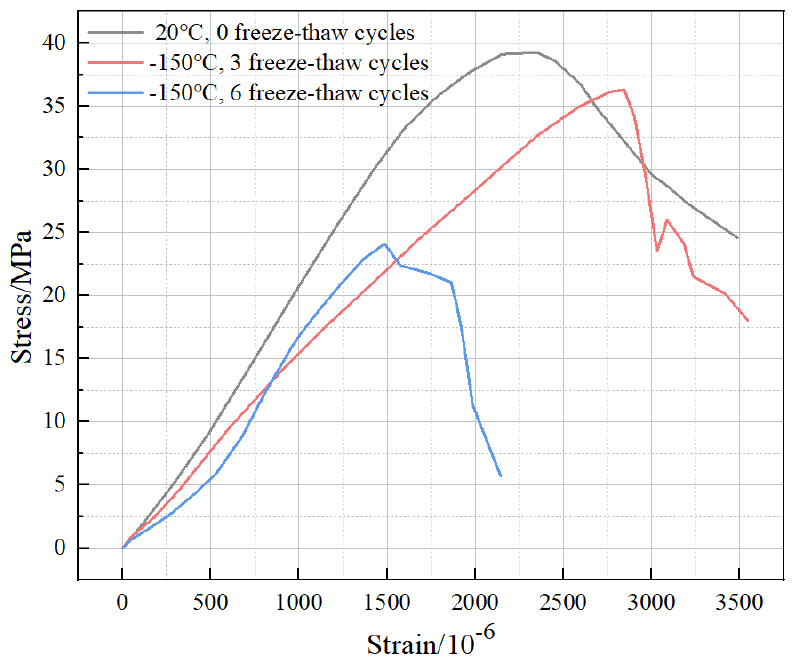
Figure 13. Effect of the number of freeze–thaw cycles on the stress–strain curve of BFRC (0.2% doping, 20 °C and − 150 °C conditions).